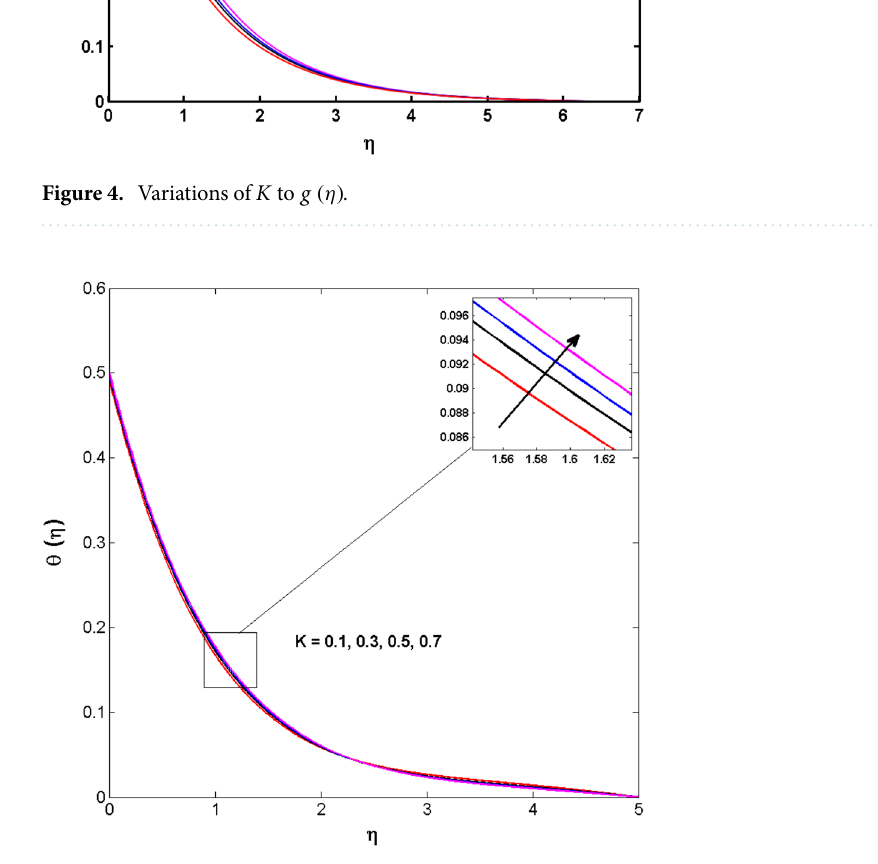
Figure 5. Variations of K to θ (η)